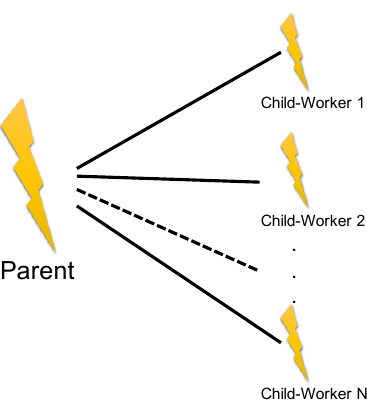
Figure 3. Multicore tasks implementation on Ryu.